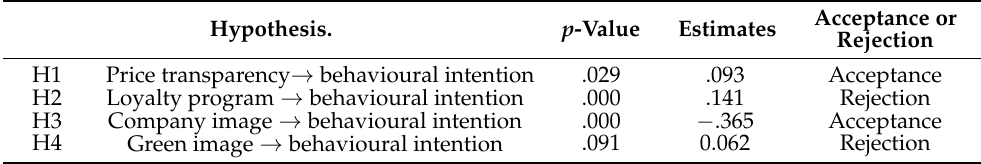
Figure 3. Summary of the research results (L group). Note: ** p < .001; * p < .05 ns — nonsignificant.